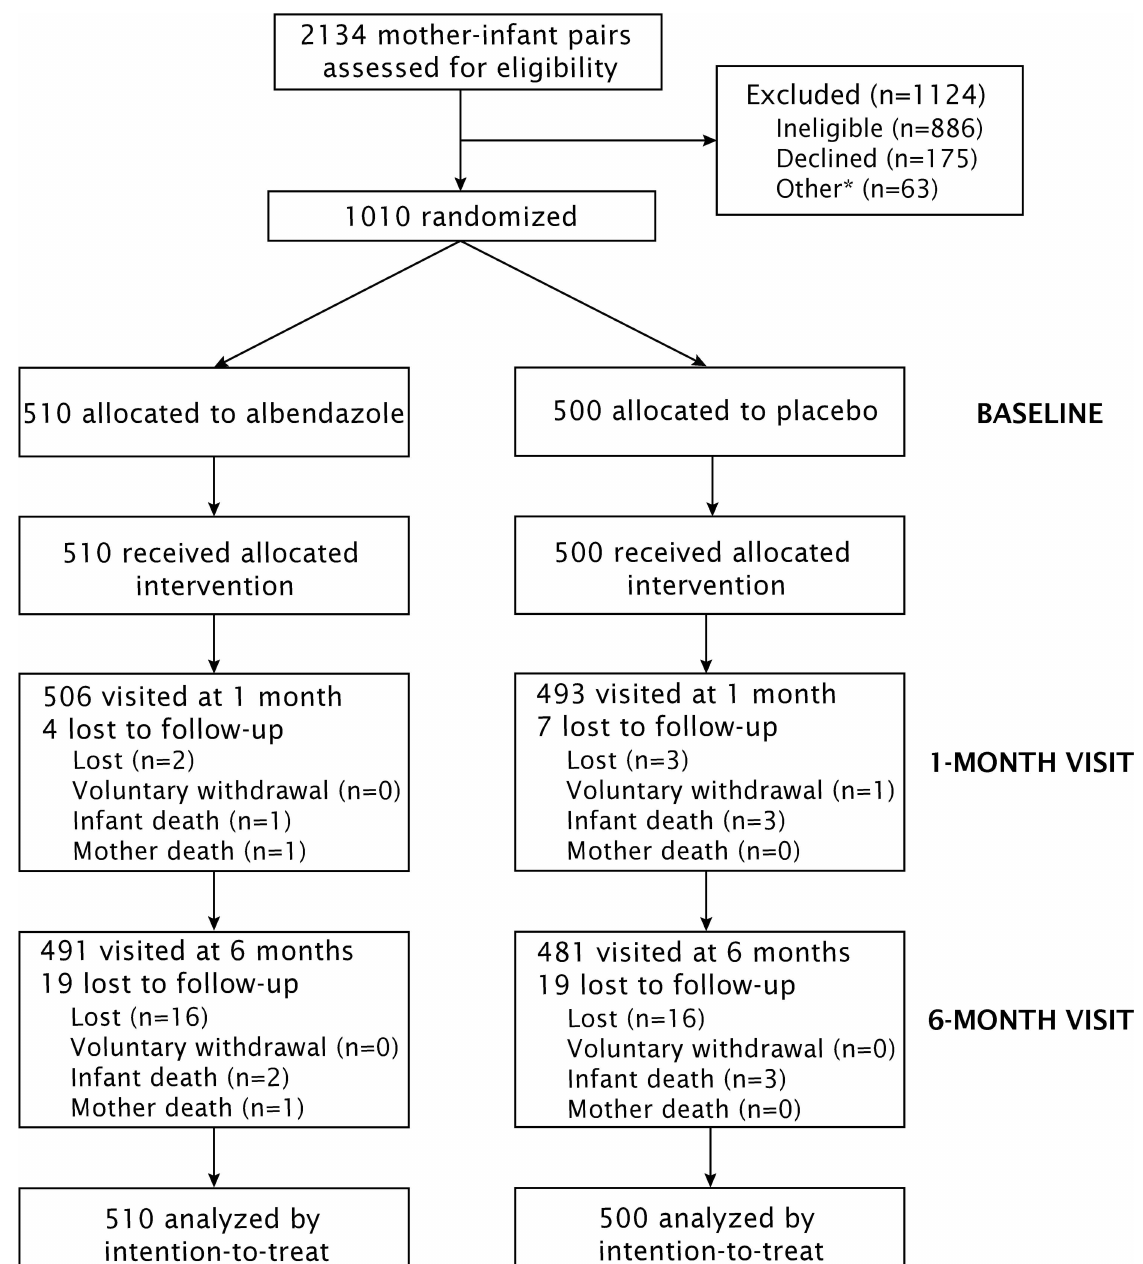
Fig 1. CONSORT trial flow diagram. * 63women were pre-recruited but were not enrolledbecausethe sample size was already met. It should be noted that some participants who were lost to follow-upat the 1-month visit were recuperated at the 6-month visit.